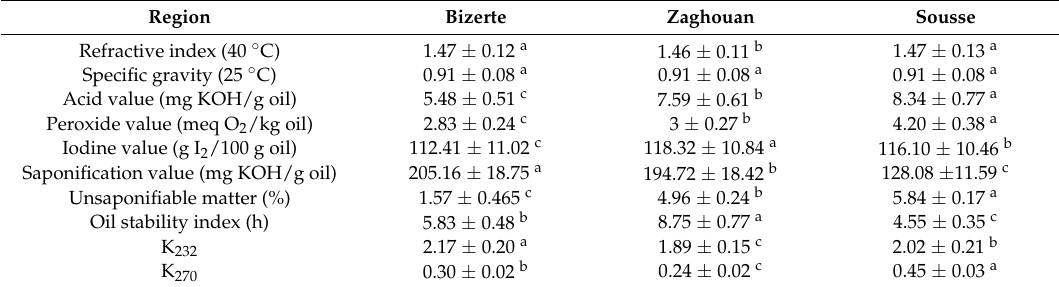
Table 1. Physicochemical characterization of cold pressed milk thistle seed oils originating from Tunisia.